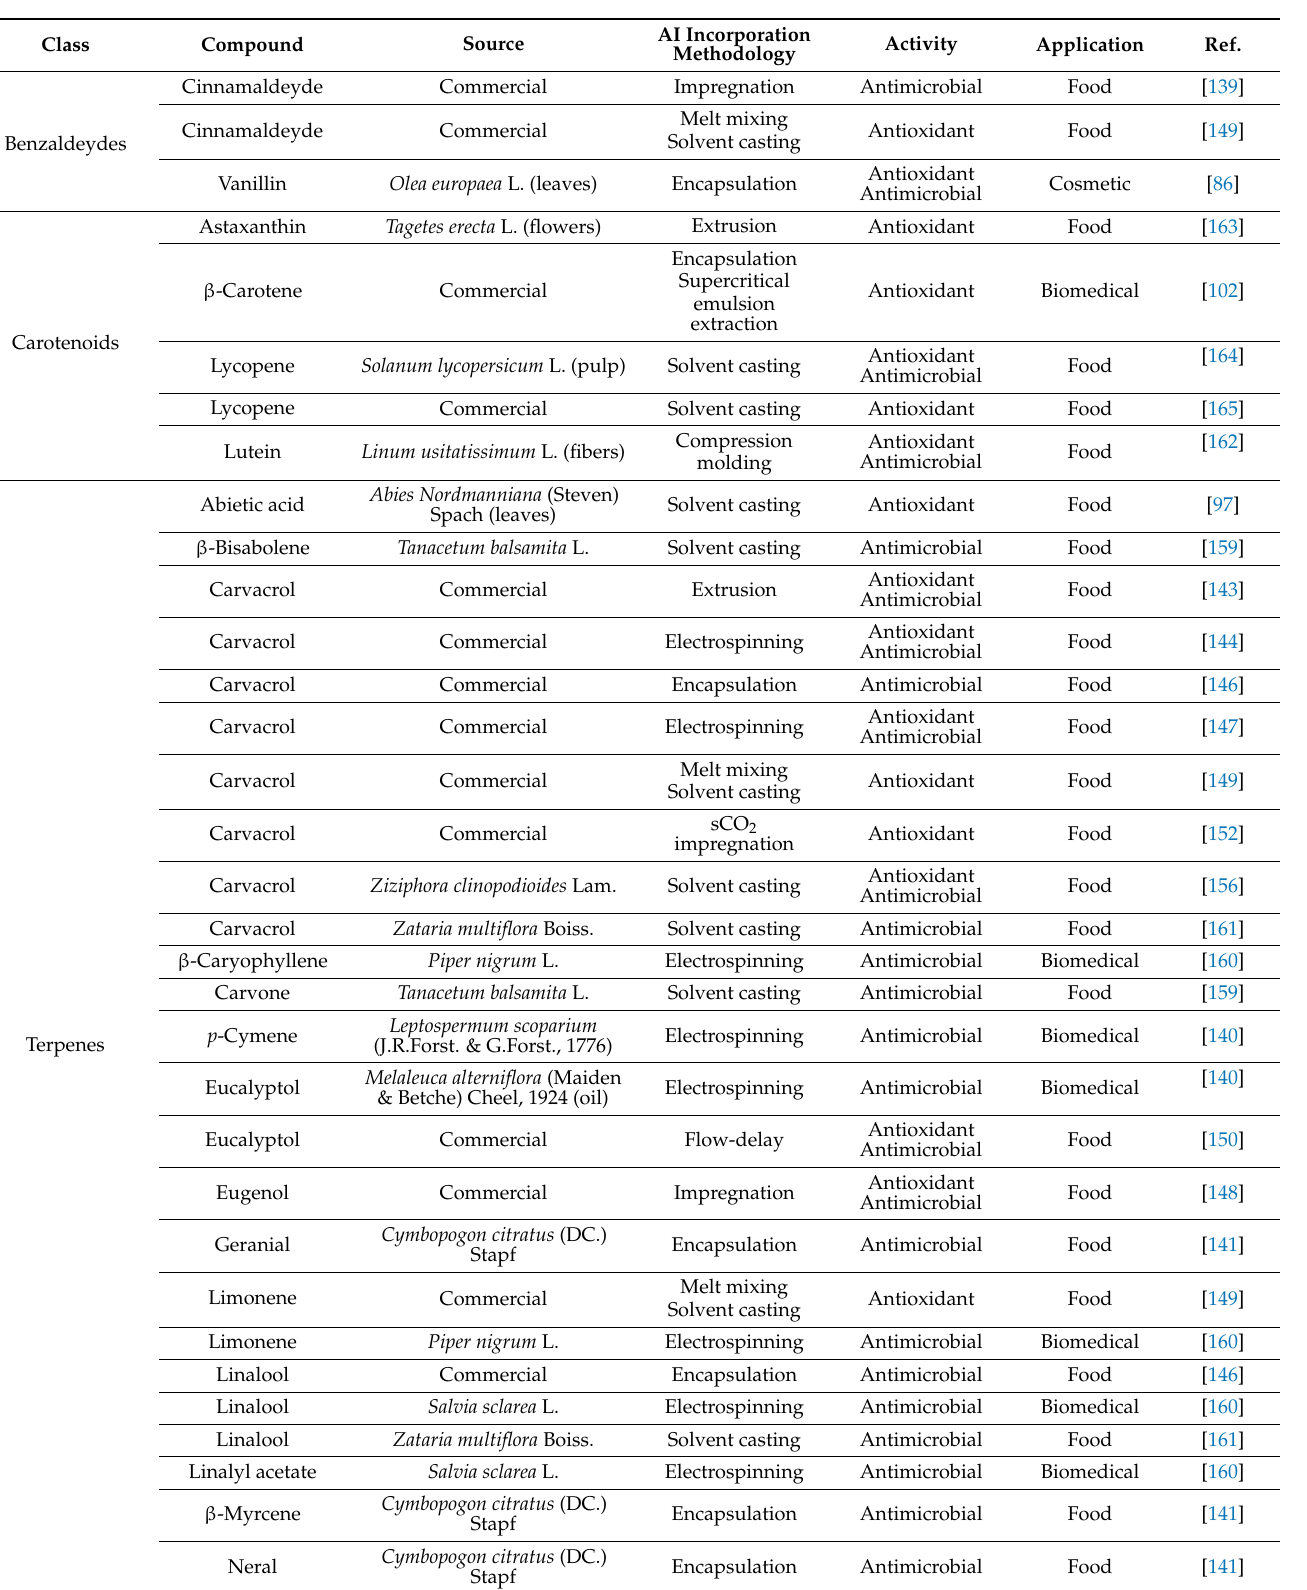
Table 2. Benzaldeydes and terpenes used as AIs for PLA-based